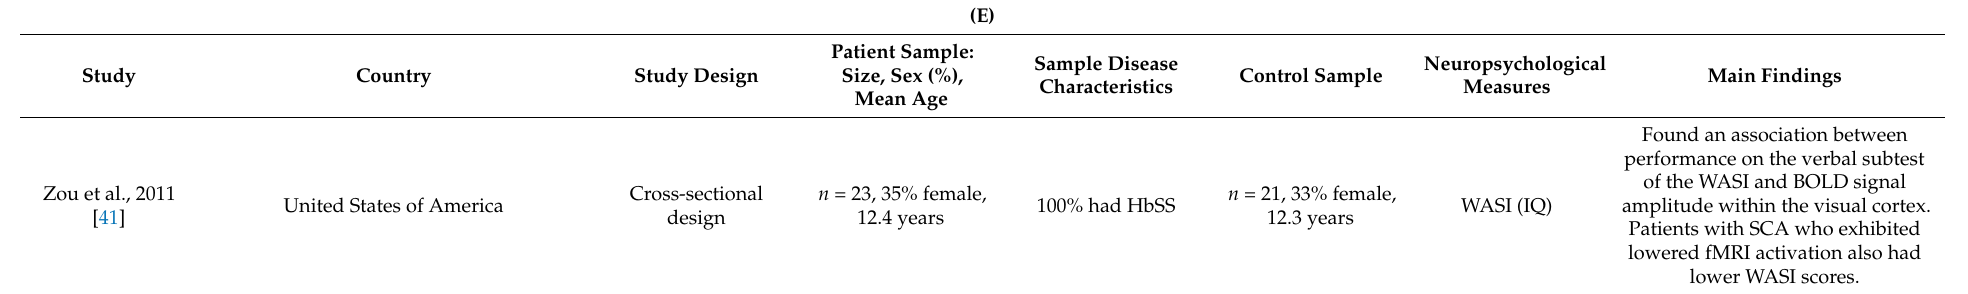
Study Country Study Design Zou et al., 2011 [41]